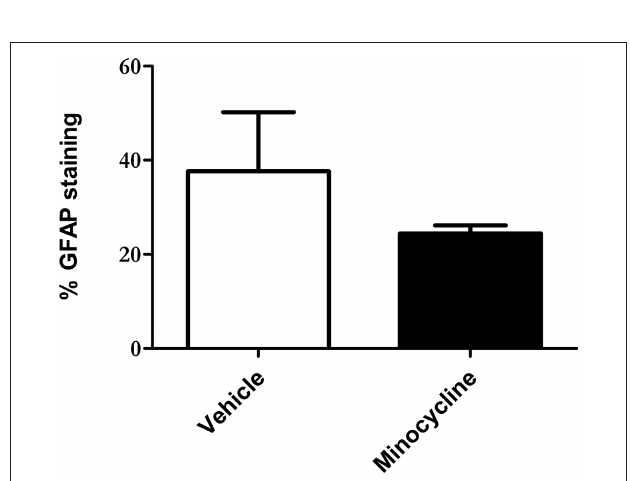
Figure 2 | Minocycline treatment reduces gFAP immunoreactivity in the somatosensory cortex of 3- to 4-month-old htau mice. Bar chart shows GFAP labeling as a % of total section area. Values represent mean ± SEM. n =